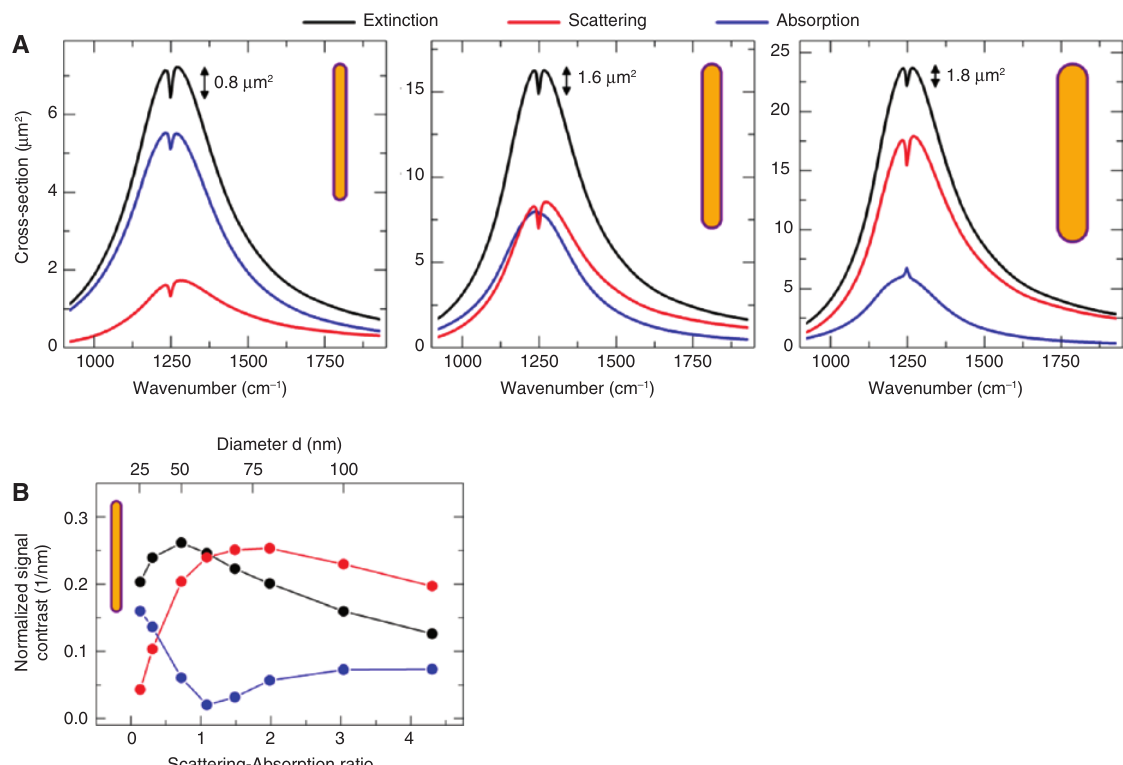
Figure 2: (A) Absorption, scattering, and extinction cross-section spectra of a dominantly absorbing antenna (left, d = 35 nm, l = 2.45 μ m), a larger antenna with scattering approximately equal to absorption (middle, d = 60 nm, l = 2.97 μ m), and an antenna that dominantly scatters (right, d = 100 nm, l = 3.2 μ m). The resonance frequency of the hosting antennas is kept at approximately 1250 cm −1 . The sample is a dielec- tric layer homogeneously covering the antenna surface (thickness t = 10 nm). (B) Vibrational signal contrast in the absorption, scattering, and extinction cross-section spectra (normalized to the volume of the dielectric layer) versus the ratio between plasmonic scattering and absorption for fixed plasmonic resonance frequency and varying volume of the hosting antenna. Adapted with permission from Ref. [27]. Copyright 2015 American Chemical